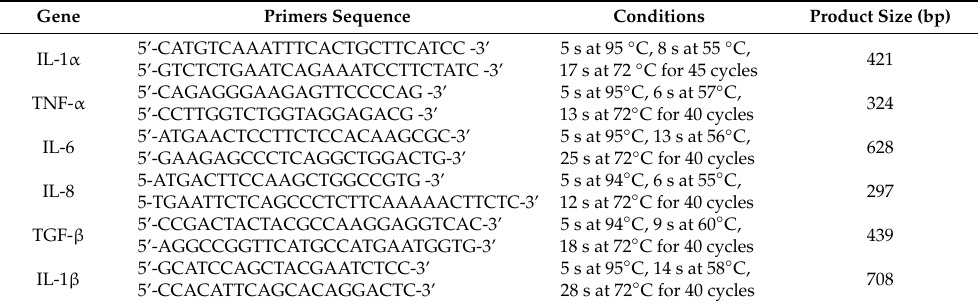
Table 3. Primer sequences and RT-PCR